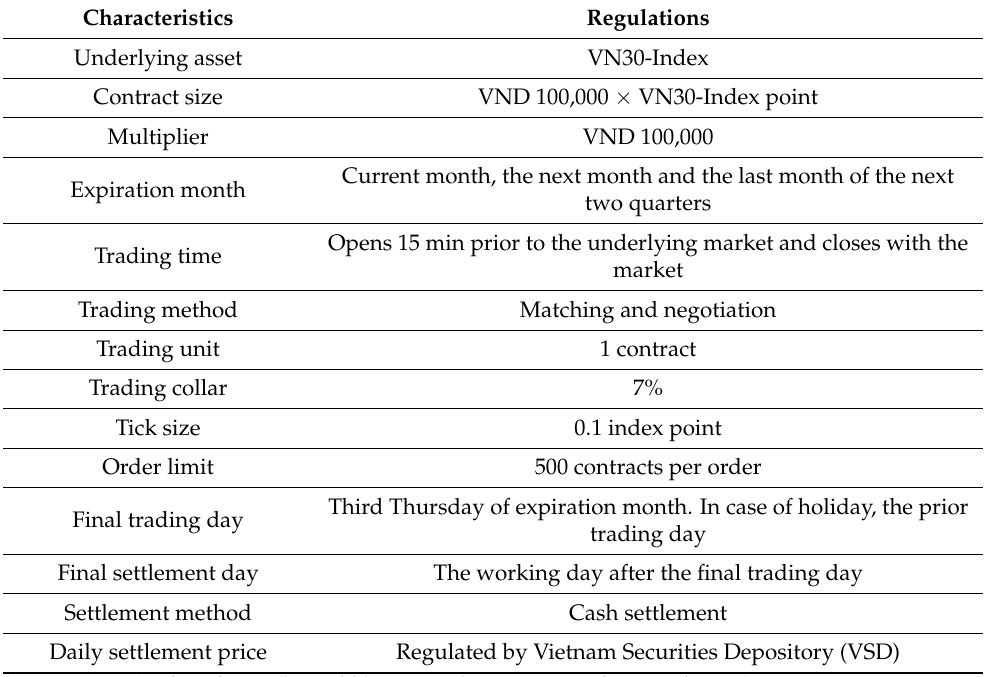
Table 1. Contract specification for the VN30-Index Futures.